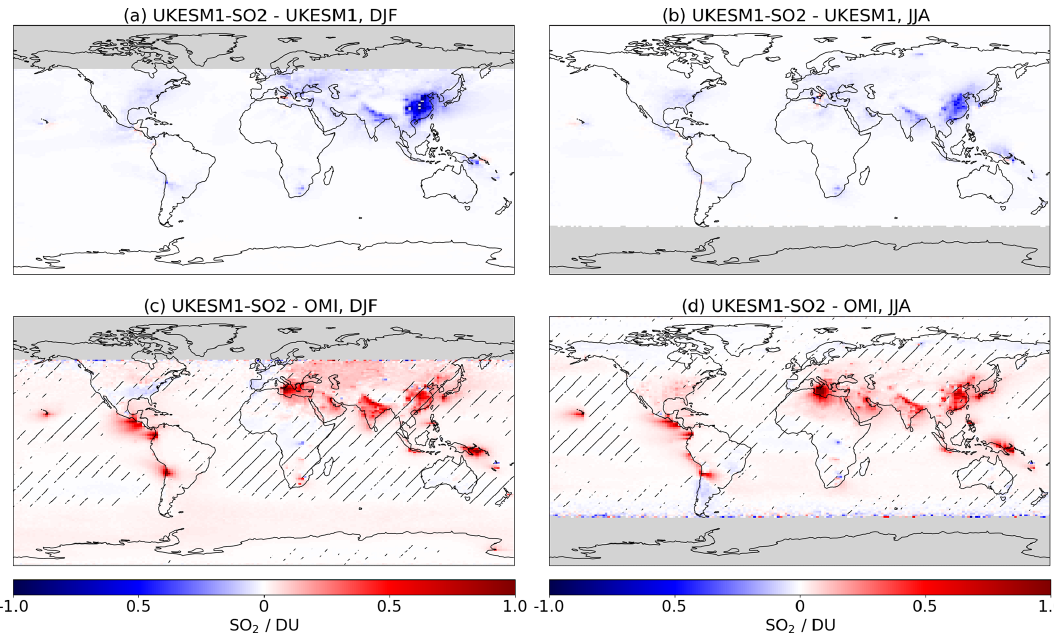
Figure 13. Difference in TCSO 2 between UKESM1 and UKESM-SO2 for DJF (a) and JJA (b) . Difference in TCSO 2 between UKESM1- SO2 and OMI for DJF (c) and JJA (d) . Model and satellite data are averaged over the period 2005–2014. The hatched regions show where the inter-model differences are smaller than the existing model–satellite